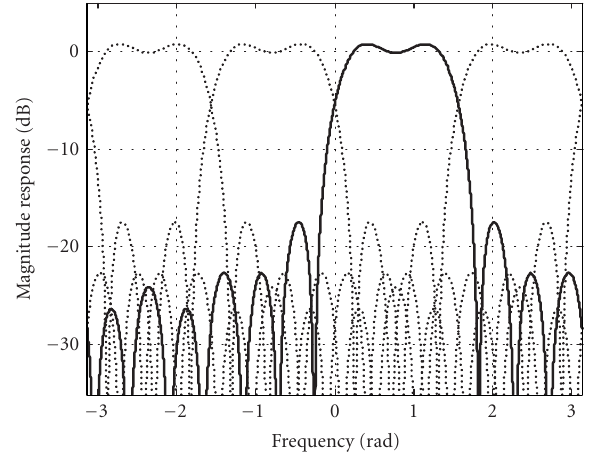
Figure 9: Magnitude response of the 4-band sub-filter bank. The response for m = 0 is